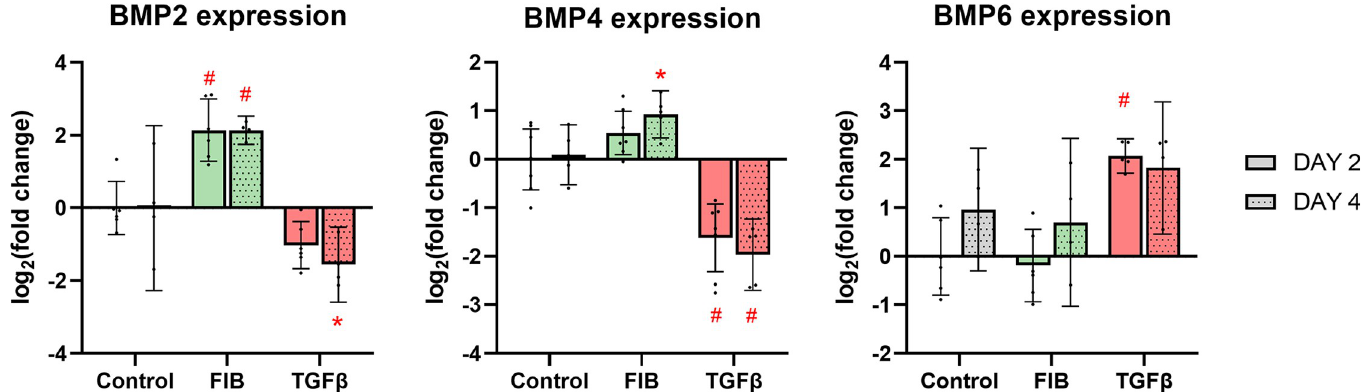
Fig 10. FGF-2 upregulates BMP2 expression. RT-qPCR results of BMPs 2, 4, and 6. In a mixed effects model, experimental groups were compared to control at each time point. � p < 0.05, #p < 0.01, dots represent biological replicates (n = 7 on day 2, n = 5 on day 4), error bars represent 95% CI.